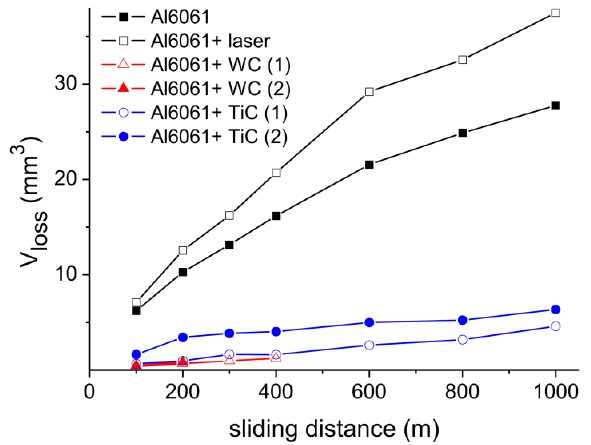
Figure 9. Volume losses calculated for investigated samples: reference Al6061, reference laser-treated alloy, two MMC layers with injected WC powder and two Al6061 + TiC samples made in different experimental conditions.